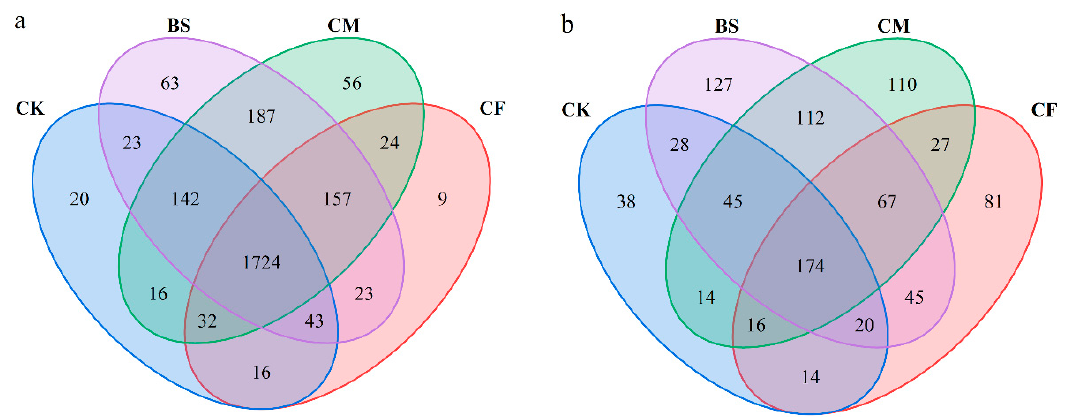
Figure 1. Venn diagram for bacterial ( a ) and fungal ( b ) operational taxonomic units (OTUs) found under different fertilization treatments. CK: Control Group, CF: Chemical Fertilizer, CM: Composted Manure, BS: Biogas Slurry.